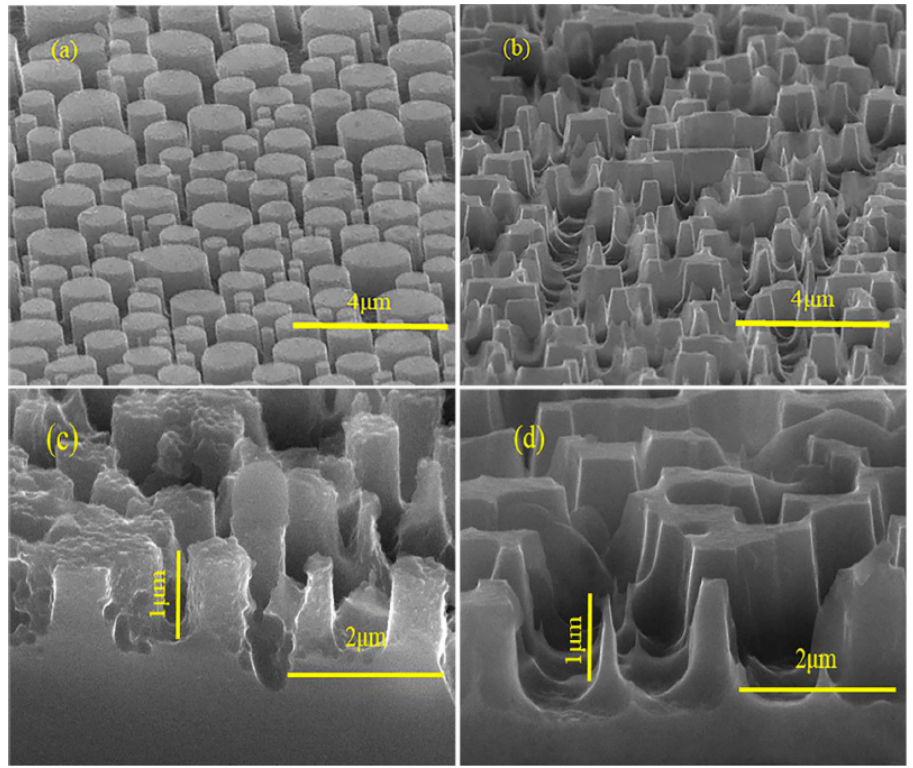
Figure 11. SEM micrographs of the composite ( a , c ) nanorods and of ( b , d ) (Reprinted with permis- sion from Ref. [125]; copyright © 2022 Elsevier B.V. All rights